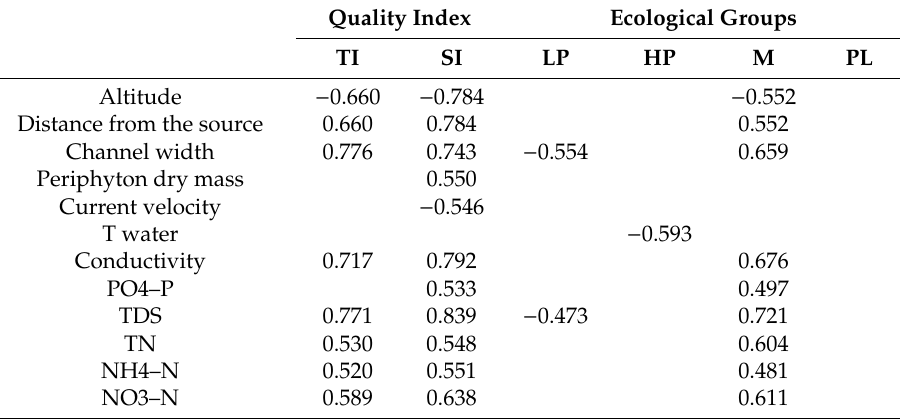
Table 1. Spearman correlation coefficients ( ρ ) between quality indices, ecological groups of diatoms and environmental parameters. Statistically significant ( p < 0.05) correlations are shown only. TI—trophic index, SI—saprobic index, LP—low profile species, HP—high profile species, M—motile species, PL—planktonic species.